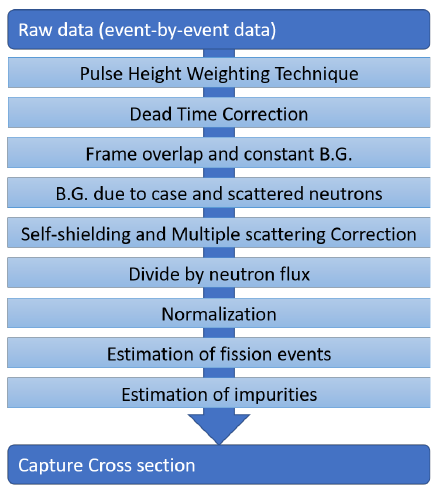
Figure 3. Flow chart of the data analysis procedure for the cap- ture cross-section measurement.